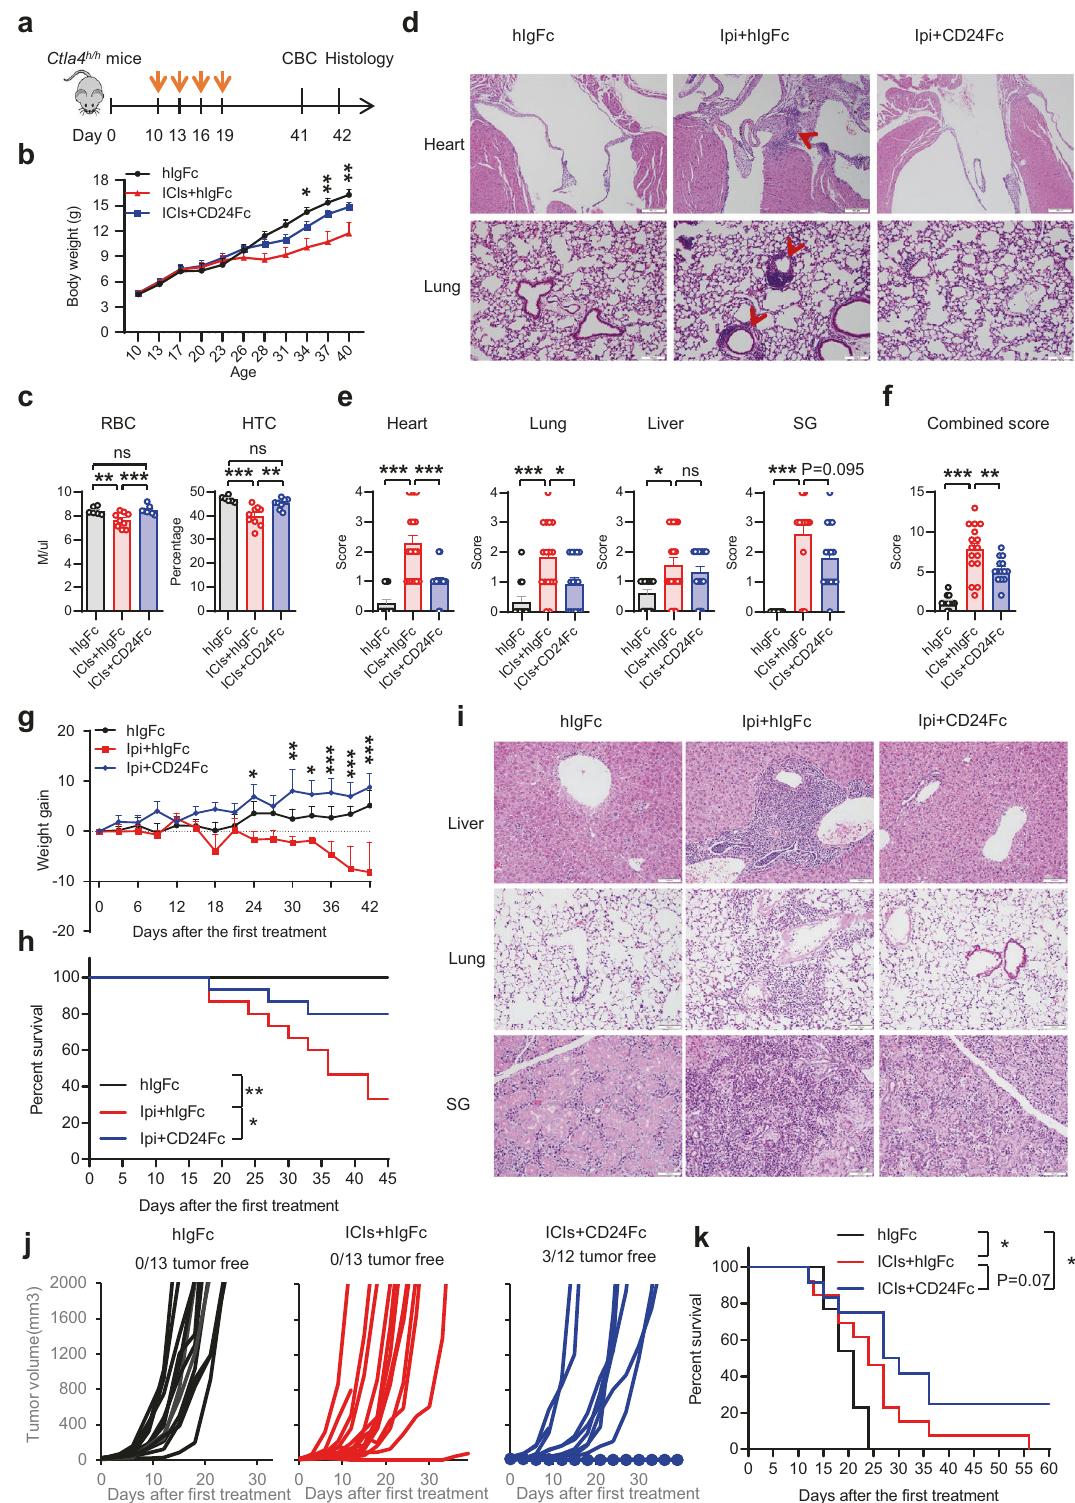
cytokines, which suggests that CD24Fc may not directly affect Tregs differentiation from naïve T cells if exogenous cytokines are provided. It is possible that the effect of CD24Fc on Treg frequency in TME relates to its repression of in fl ammatory cytokines. 10